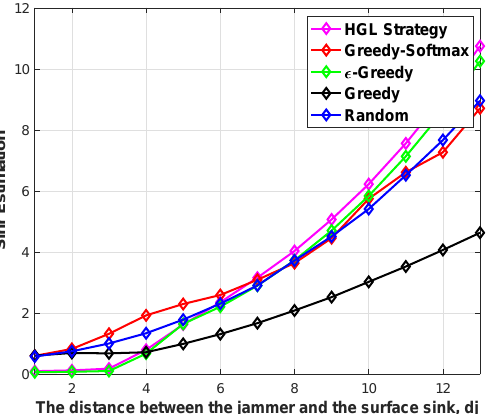
Figure 8. The utility varies with the distance d j between node S 2 and node S 1 .